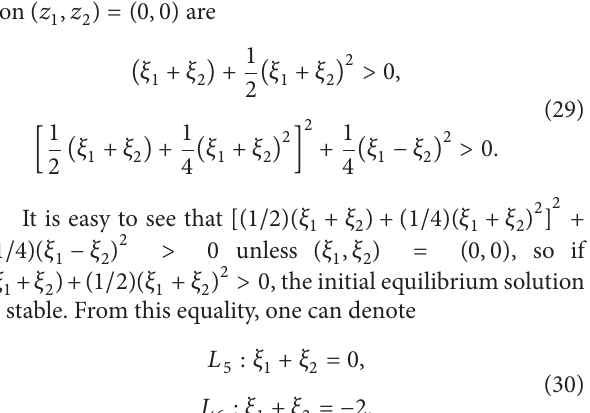
Figure 7: Bifurcation diagram on detuning parameters for the case of double zero and two negative